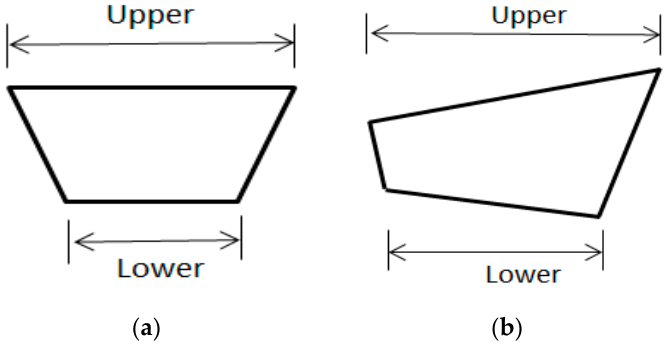
Figure 18. How to measure the length of horizontal sides. ( a ) If horizontal sides are parallel ; ( b ) If horizontal sides are not parallel .